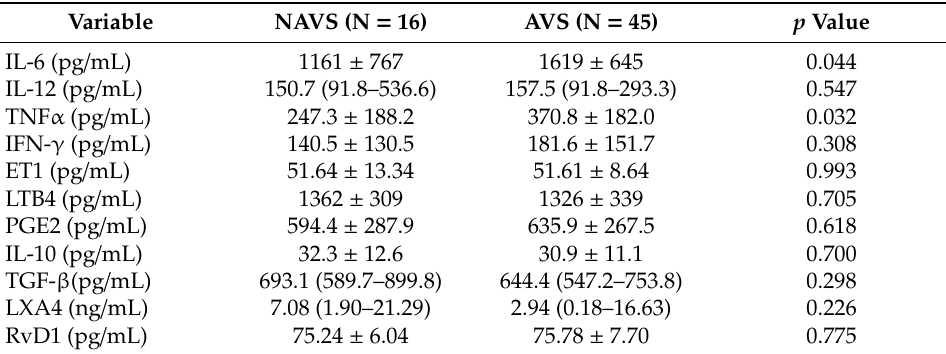
Table 3. Markers of the inflammation process.